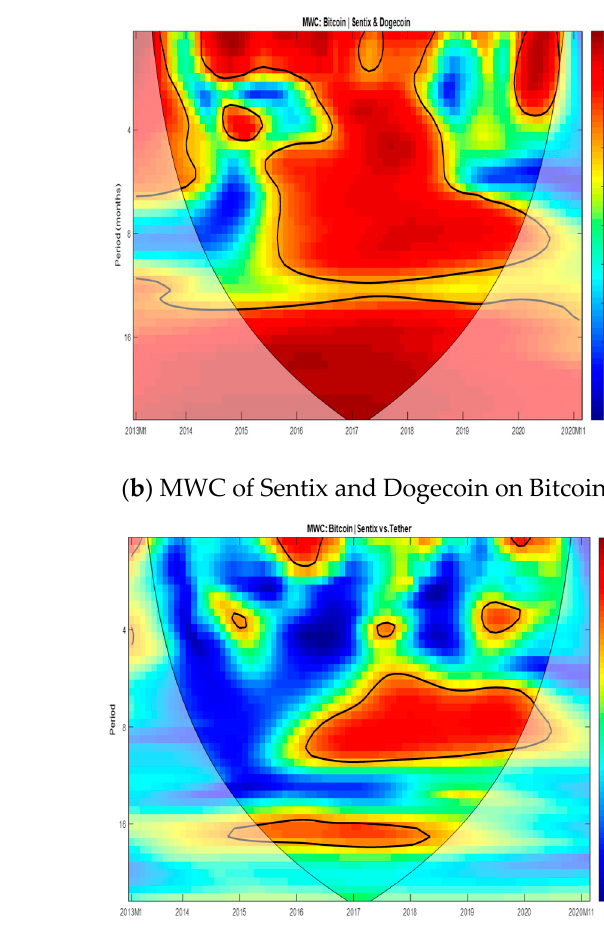
axes denote time and scale bands, respectively. Overall, when looking at the PWC plots, we show that highest coherencies are spread in the middle horizon.